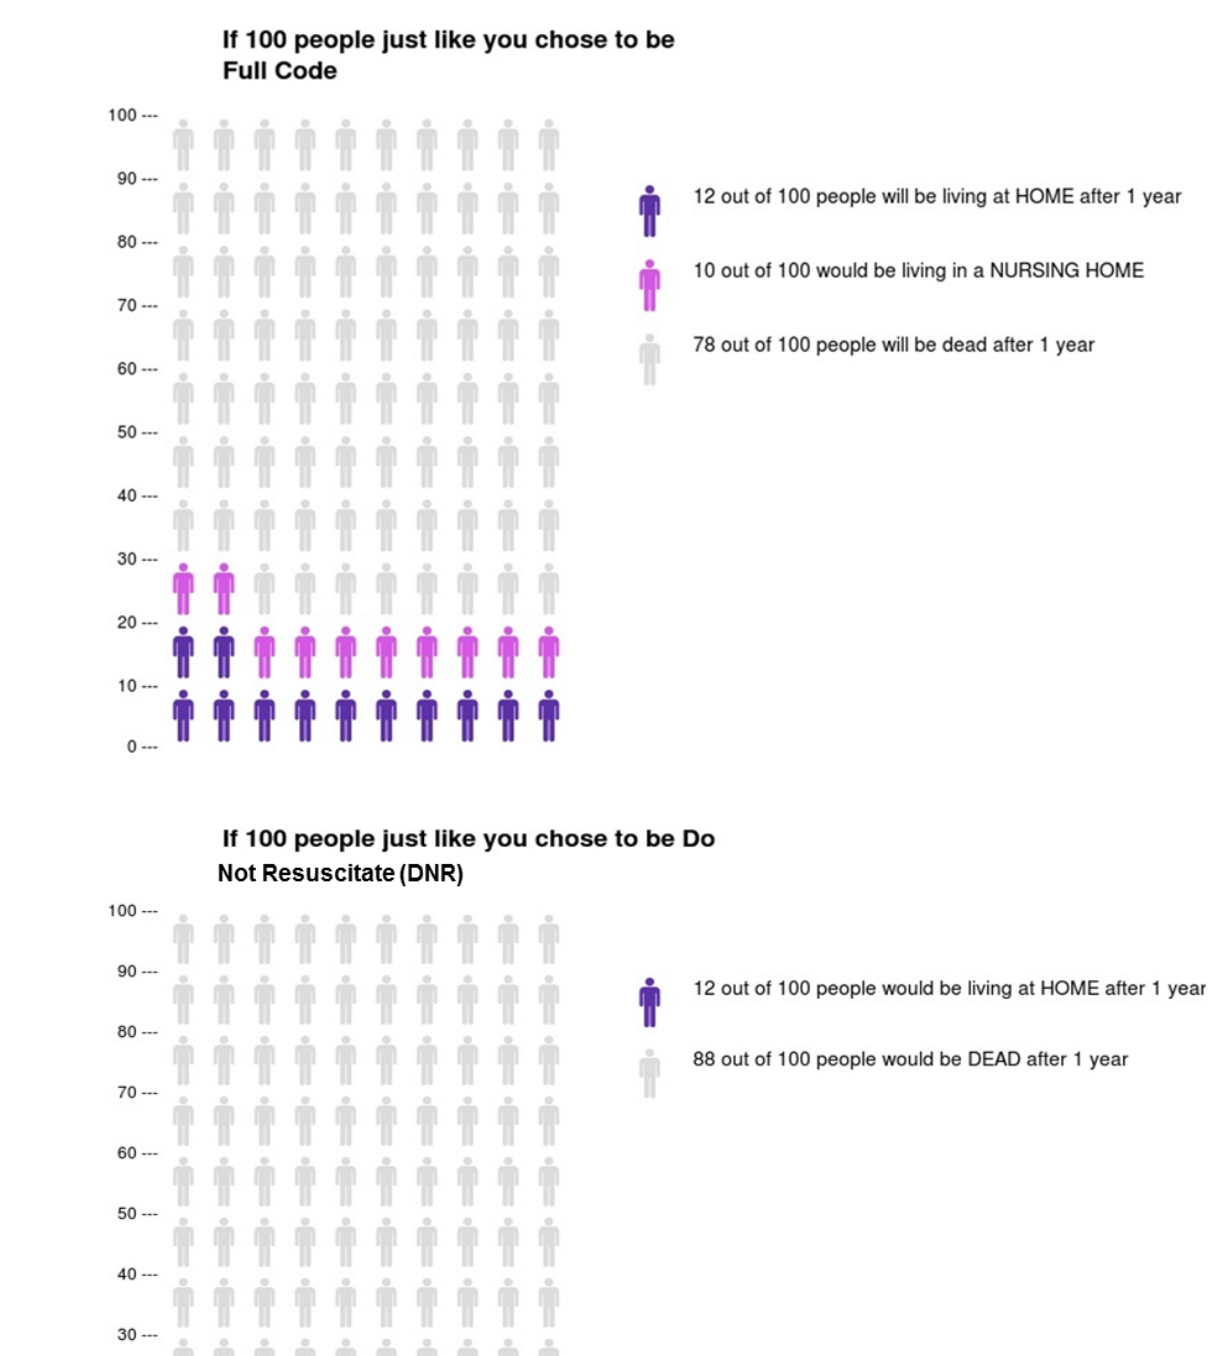
Figure 1. Icon arrays presented in phase 1 of usability testing. Likely outcomes 12 months after hospitalization for acute COPD exacerbation are shown for 100 hypothetical patients choosing either a Full Code or DNR advance